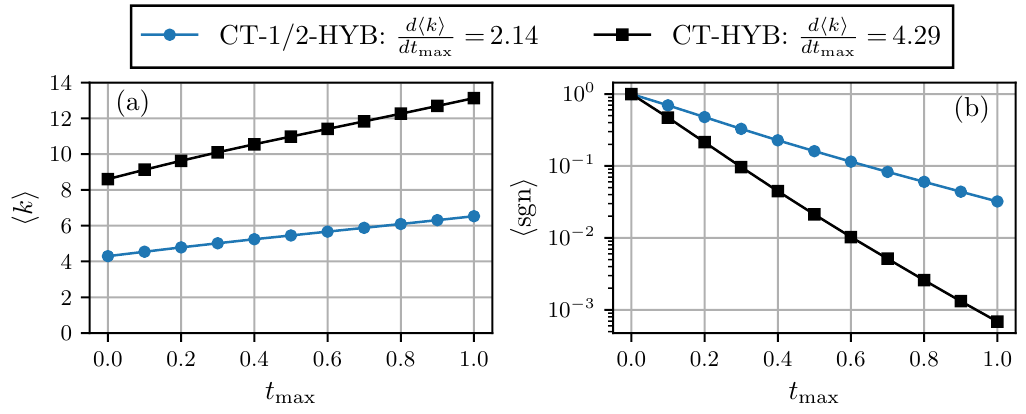
Figure 4: (a) Average expansion order as a function of t growth rate for CT-1 / 2-HYB is twice as low as for CT-HYB (estimated values based on a linear fit starting from t = 0.4). (b) Average Monte Carlo sign as a function